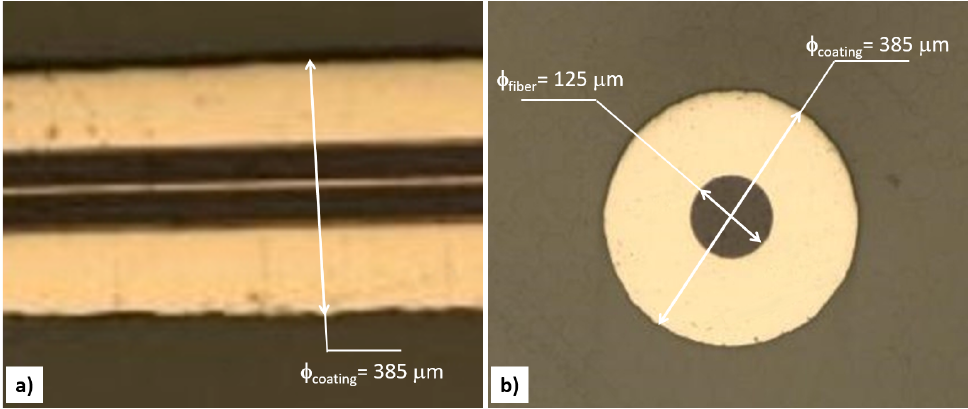
Figure 4. External appearance of Ni-electrodeposited coating.